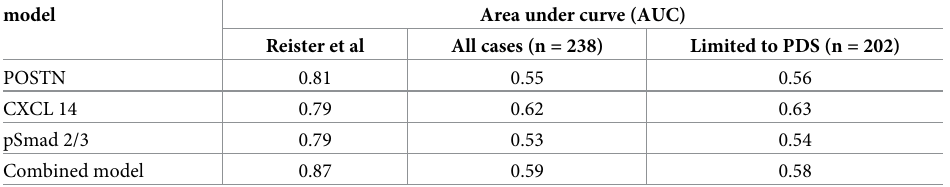
Table 4. Comparison of AUC between each study cohort and for each